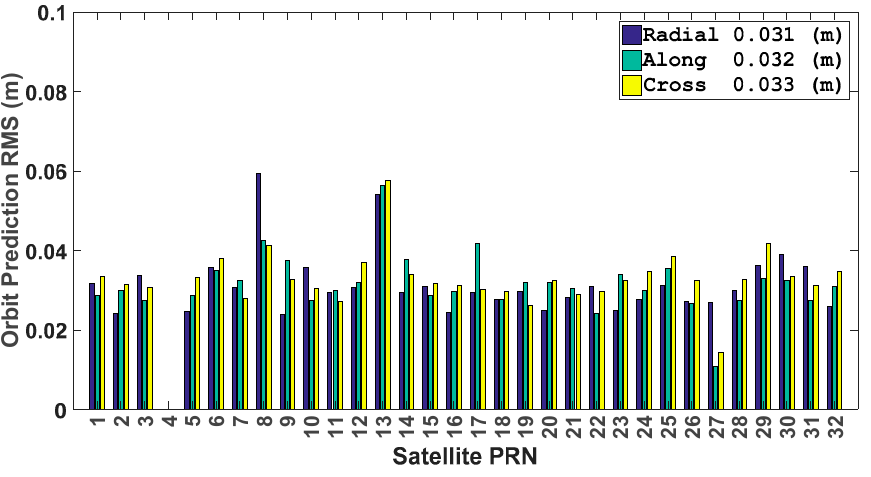
Figure 5. Average orbit prediction RMSE over 12 h of all GPS satellites from DOY 106 to 112 of 2017.